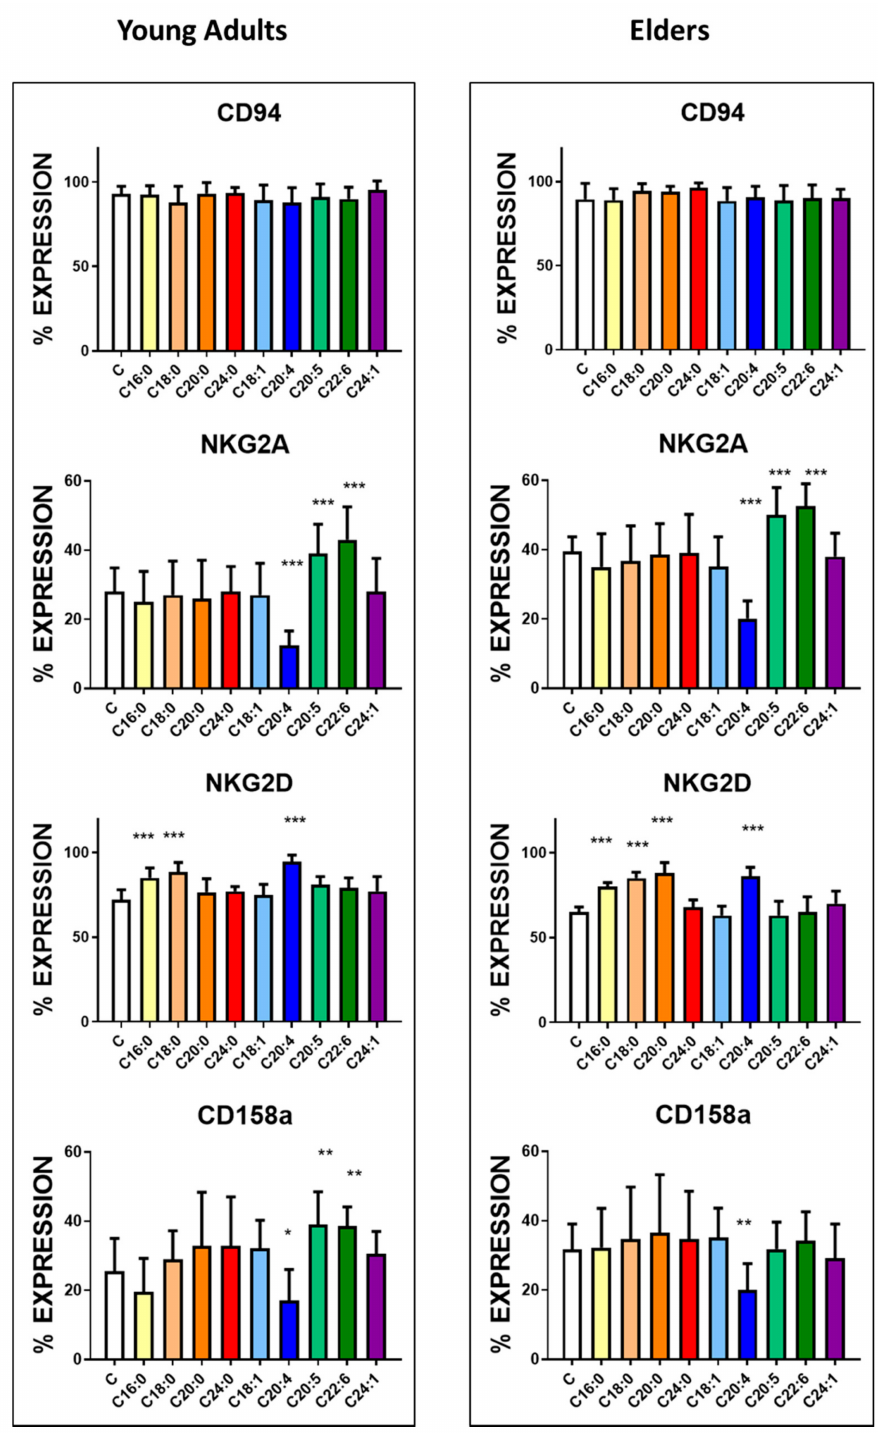
Figure 1. E ff ect of fatty acids treatment on the mean percentage expression of CD94, NKG2A, NKG2D and CD158a antigens. NK cells purified from the blood of the healthy young adults (23 ± 4 years old) and healthy elders (63 ± 5 years old) were treated with 10 µ g / mL concentration of the following fatty acids for 24 h. The expression of the receptors was assessed by flow cytometry. The results represent the percentage mean and SD for each group ( n = 30). The treatments were compared by one way ANOVA. Bonferroni significance post-test are represented. * p < 0.01, ** p < 0.001 and *** p < 0.0001. No significant di ff erences are recorded for CD94. The mean channel fluorescent intensity (MFI) is represented in Supplementary Figure